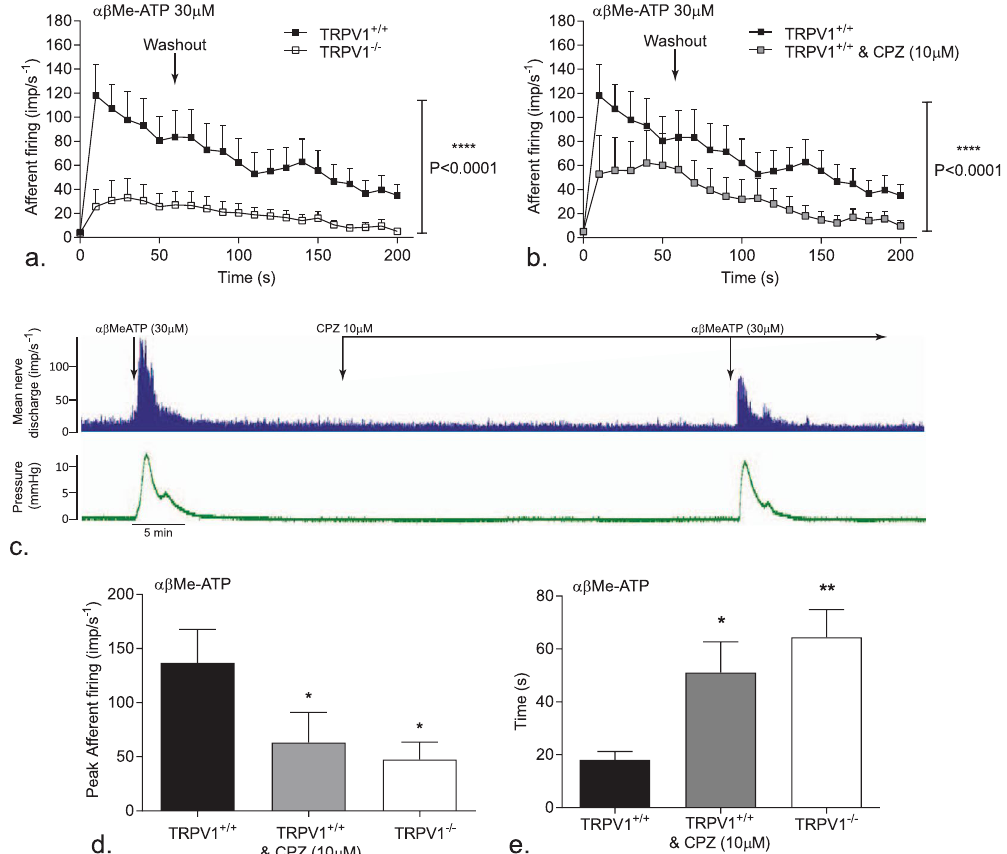
Figure 2. TRPV1 has a role in P2X mediated bladder afferent signaling. ( a ) Afferent nerve response to αβ Me- ATP(30 µ M), applied for 60 s, in bladder preparations from TRPV1 + / + and TRPV1 − / − mice. ( b ) Afferent nerve response to repeated applications of αβ Me-ATP for 60 s in bladders from TRPV1 + / + mice in the presence and absence of capsazepine; Data shown are mean ± SEM, two-way ANOVA with Tukeys post-hoc test **** p ≤ 0.0001 (n = 9). ( c ) Afferent nerve and intravesical pressure responses to repeat applications of αβ Me- ATP in TRPV1 + / + mice prior to and following incubation with capsazepine. ( d ) Peak afferent nerve responses to αβ Me-ATP (30 µ M) in TRPV1 + / + mice in the presence and absence of capsazepine, and TRPV1 − / −